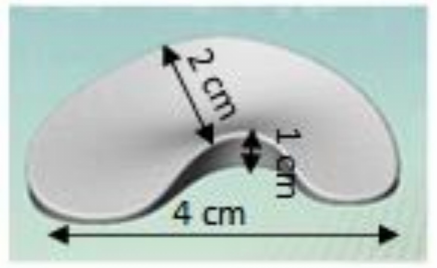
Figure 3. Computer-aided design (CAD) of meniscus implant.